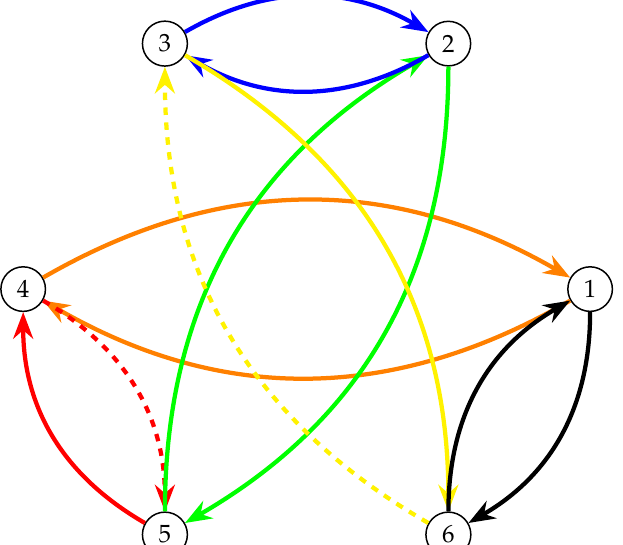
Figure 7. The new reaches obtained by resolution from the resolvable network of the pigeon hole problem shown in Figure